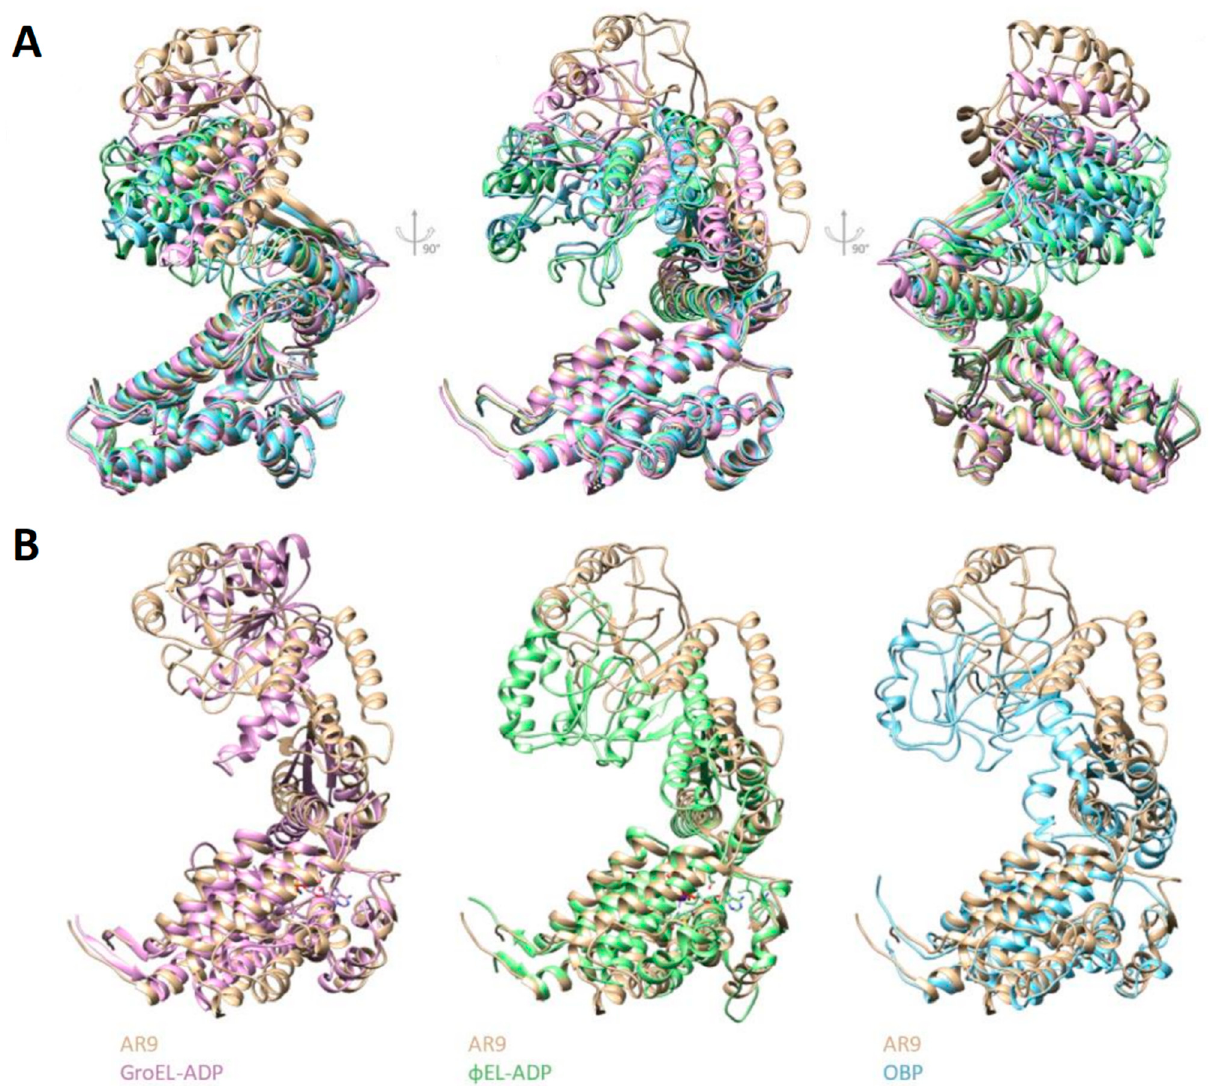
Figure 5. Comparison of subunit conformations of phage chaperonins and GroEL. ( A ) Alignment of 4 subunit conformations of the AR9 chaperonin. The first to the fourth types are colored blue, tan, green and pink, respectively. ( B ) Comparison of the second type subunit with GroEL and other phage chaperonins.